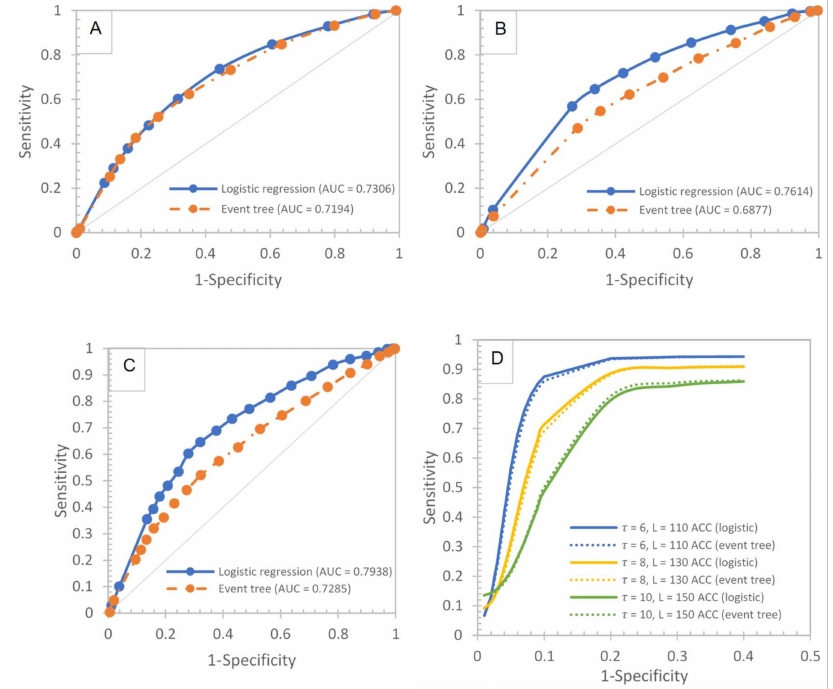
Figure 7. Comparing ROC curves of models between the regression and the event tree for different cell sizes of ( A ) τ = 6, L = 110, ( B ) τ = 8, L = 130, ( C ) τ = 10, L = 150; ( D ) Comparing the accuracy between regression and event tree of different cell sizes.